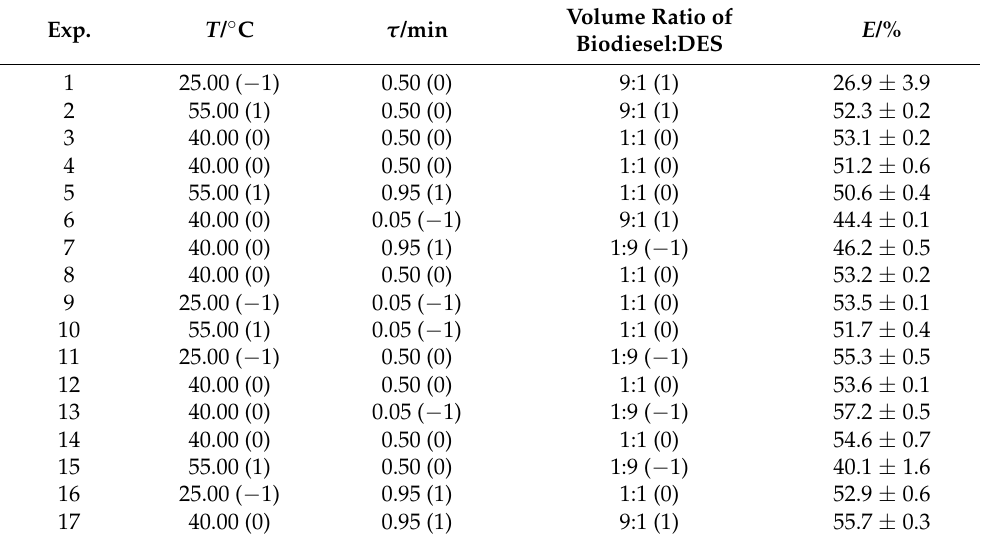
Table 6. Optimization of extraction by Box-Behnken experimental design (observed response factor levels are shown in